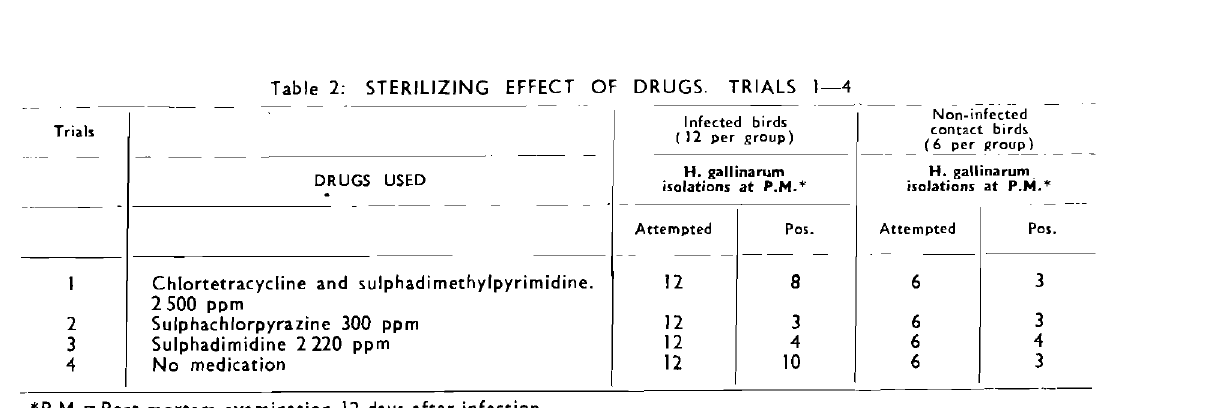
Table 3: STERILIZING EFFECTS OF DRUGS. TRIALS 9-12